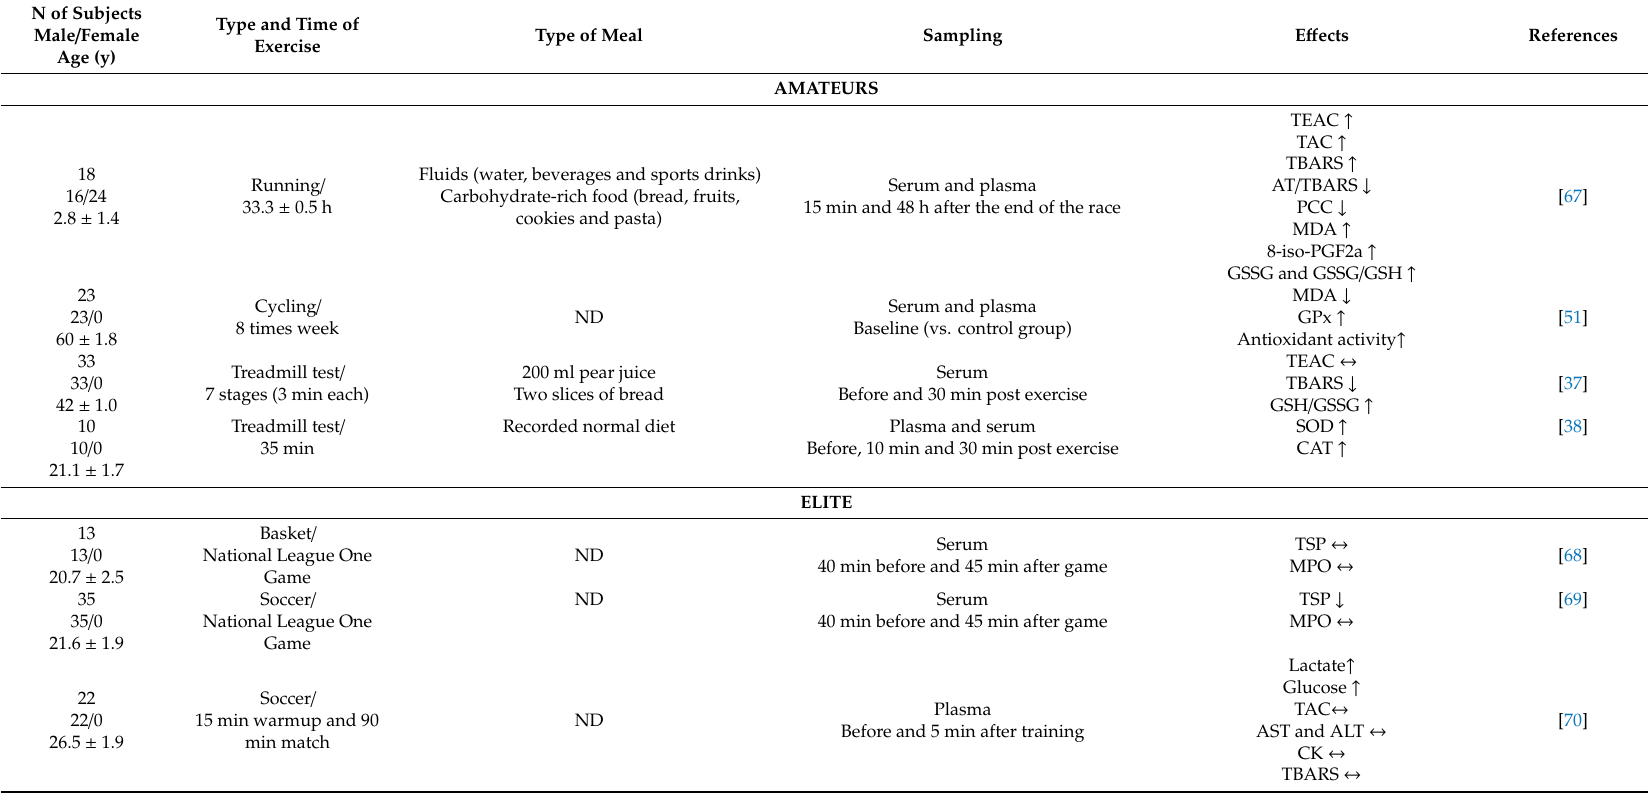
Table 1. E ff ects of di ff erent types of sports on oxidative stress, inflammation, and muscle